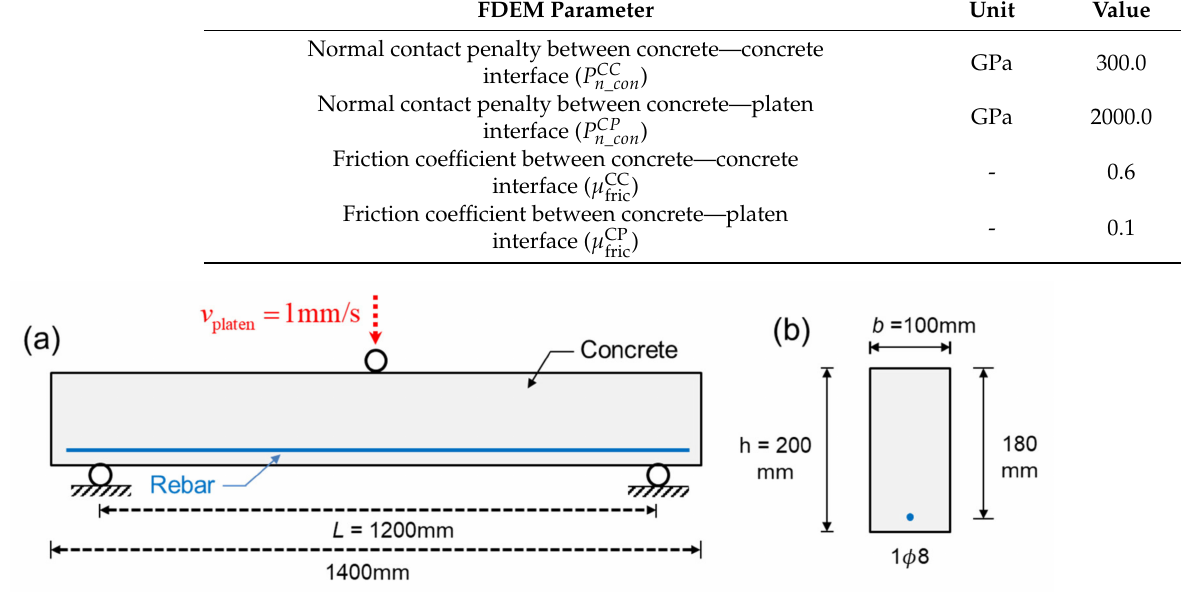
Figure 6. Schematic diagrams showing ( a ) the RC beam and ( b ) the center cross-sectional view of the beam for the three-point bending